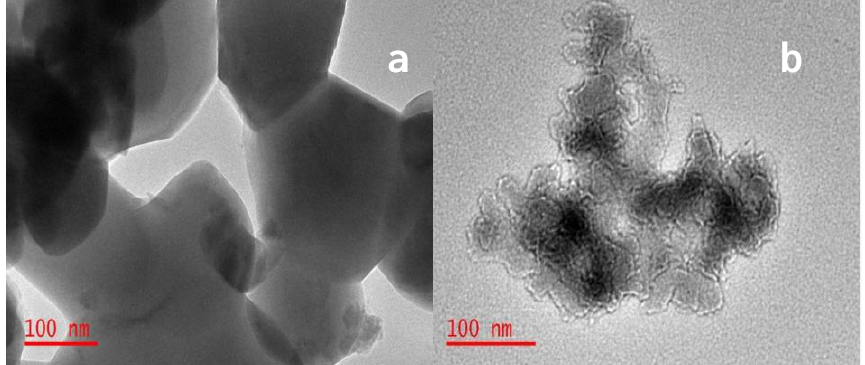
Figure 3. TEM image of ( a ) Fe 2 O 3 -SiO 2 ( b ) Fe 2 O 3 -SiO 2 -PAN.